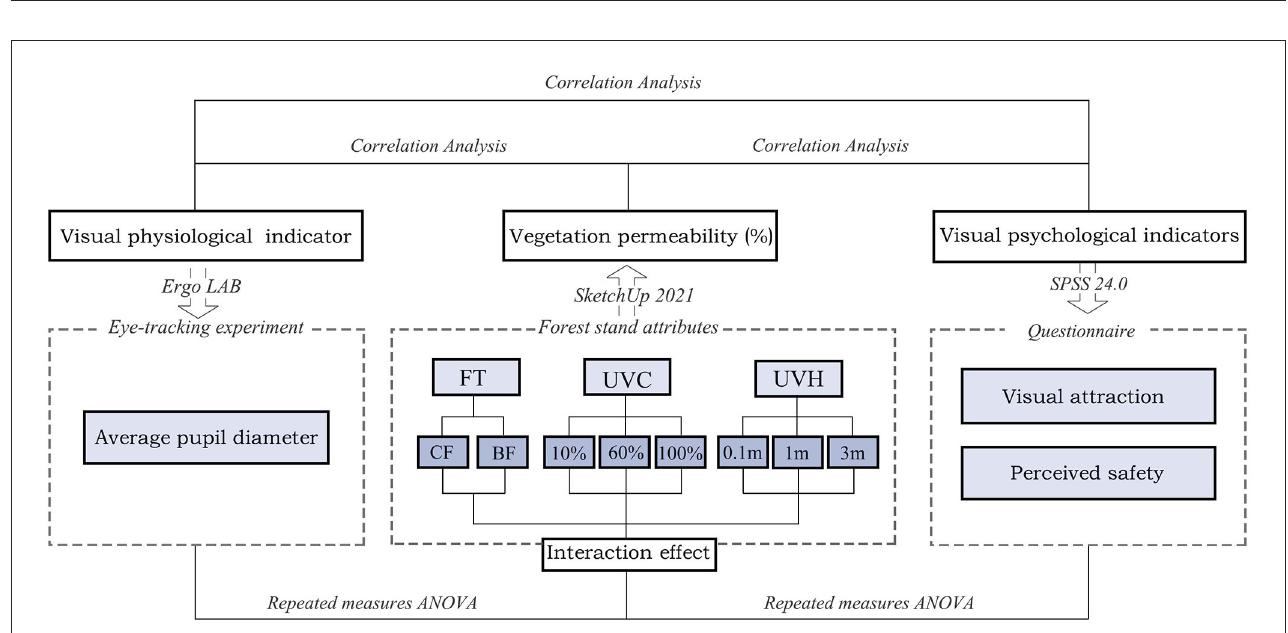
FIGURE7 Research framework. FT, forest type; UVC, understory vegetation cover; UVH, understory vegetation height; BF, broadleaved forest; CF, coniferous forest.